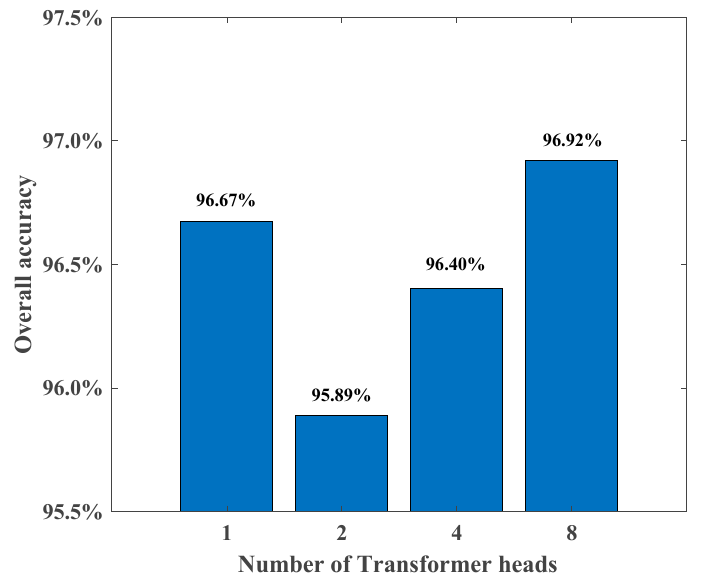
Figure 7. Effect of the number of transformer heads on classification results.